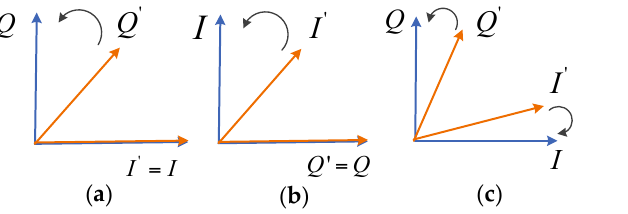
Figure 3. ( a ) Using the in-phase signal as a reference; ( b ) using the quadrature signal as a reference ( c ); using symmetric orthogonalization.